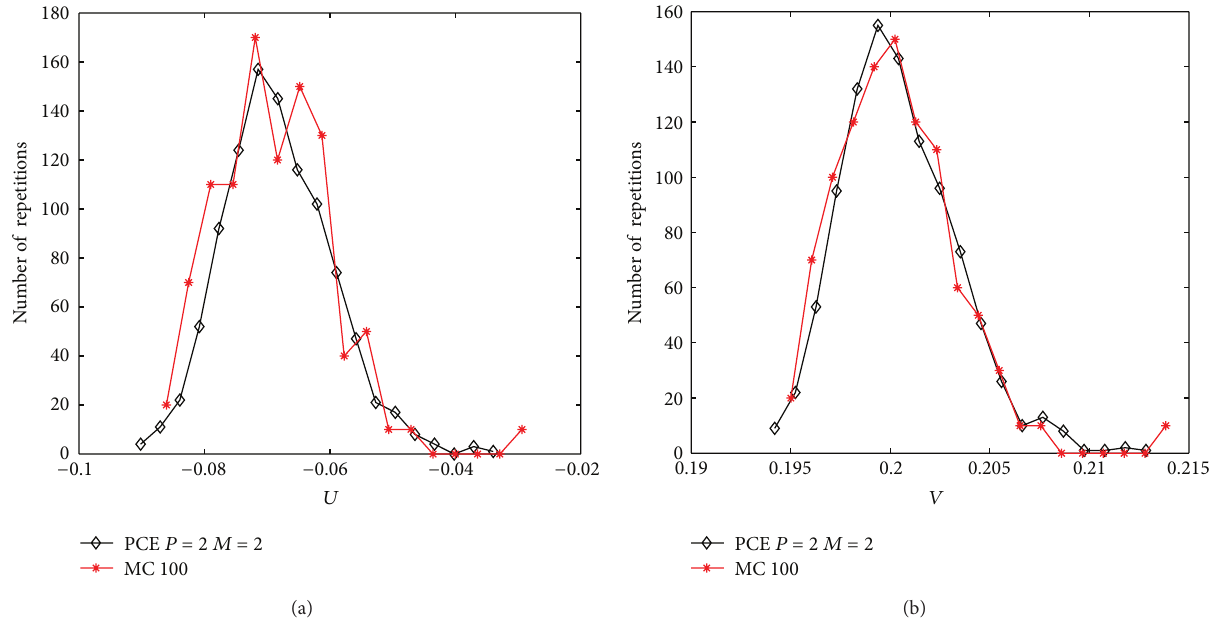
Figure 7: p.d.f of the horizontal velocity component (a) and the vertical component (b) at 𝑥 = 0.3522 and 𝑦 = 0.6494 using the current stochastic solver and MC simulations mean viscosity = 0.01 and 500 elements cavity